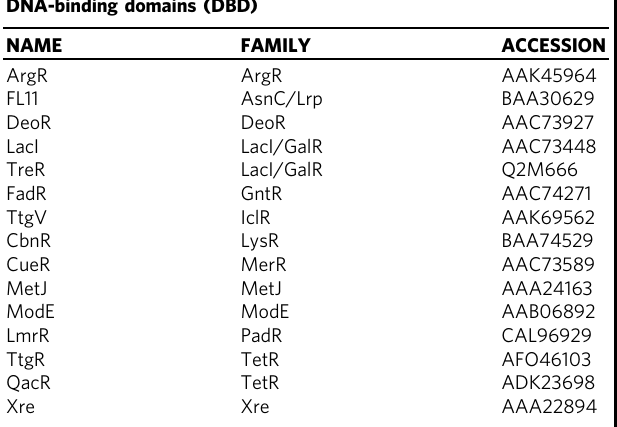
Table 1 DNA-binding domains included in the chimeric TFs DNA-binding domains